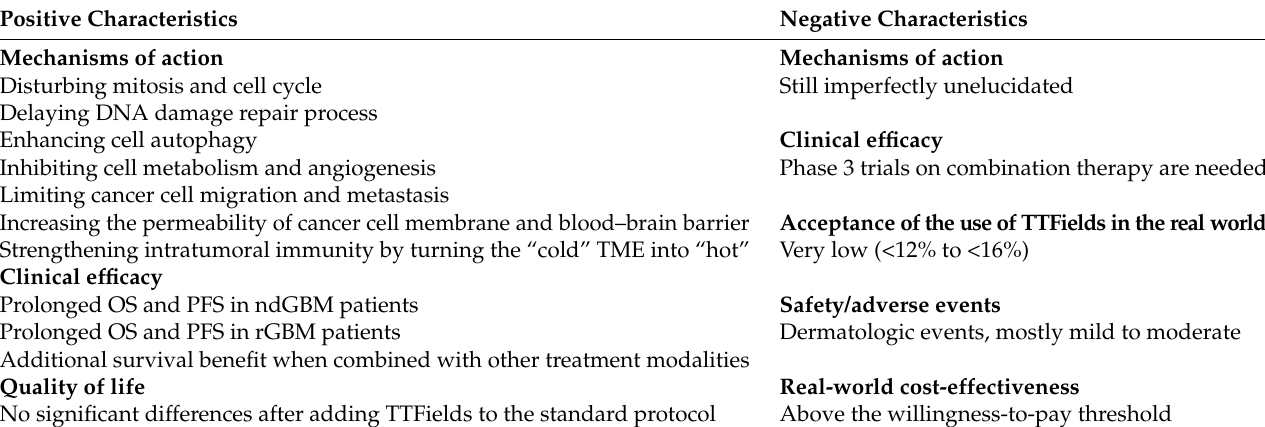
Table 3. Positive and negative characteristics of TTFields in treating